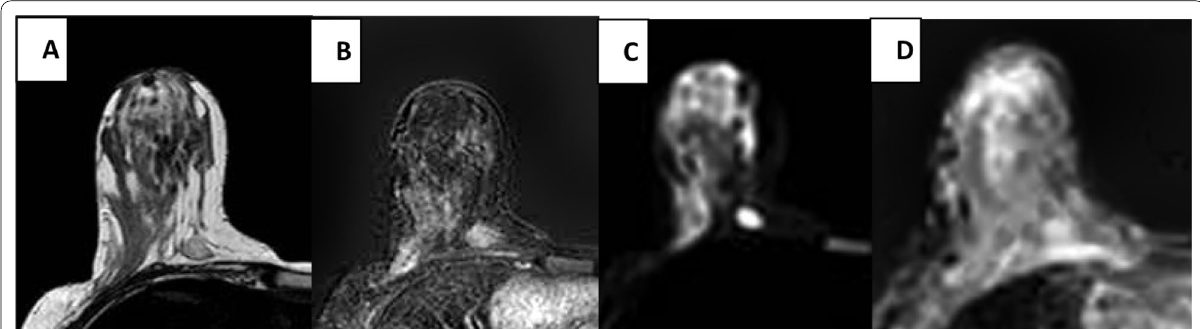
Fig. 5 A 35-year-old female with a right breast fibroadenoma. A Axial T2-WI showing a well-circumscribed lesion of low signal and dark internal septations. B Axial postcontrast T1-WI with subtraction, the lesion showed homogenous enhancement. C Axial DWI (b 1000), the lesion showed high signal. D Axial ADC map, the ADC value of the lesion was 1.09 10 − 3 mm 2 /s ×